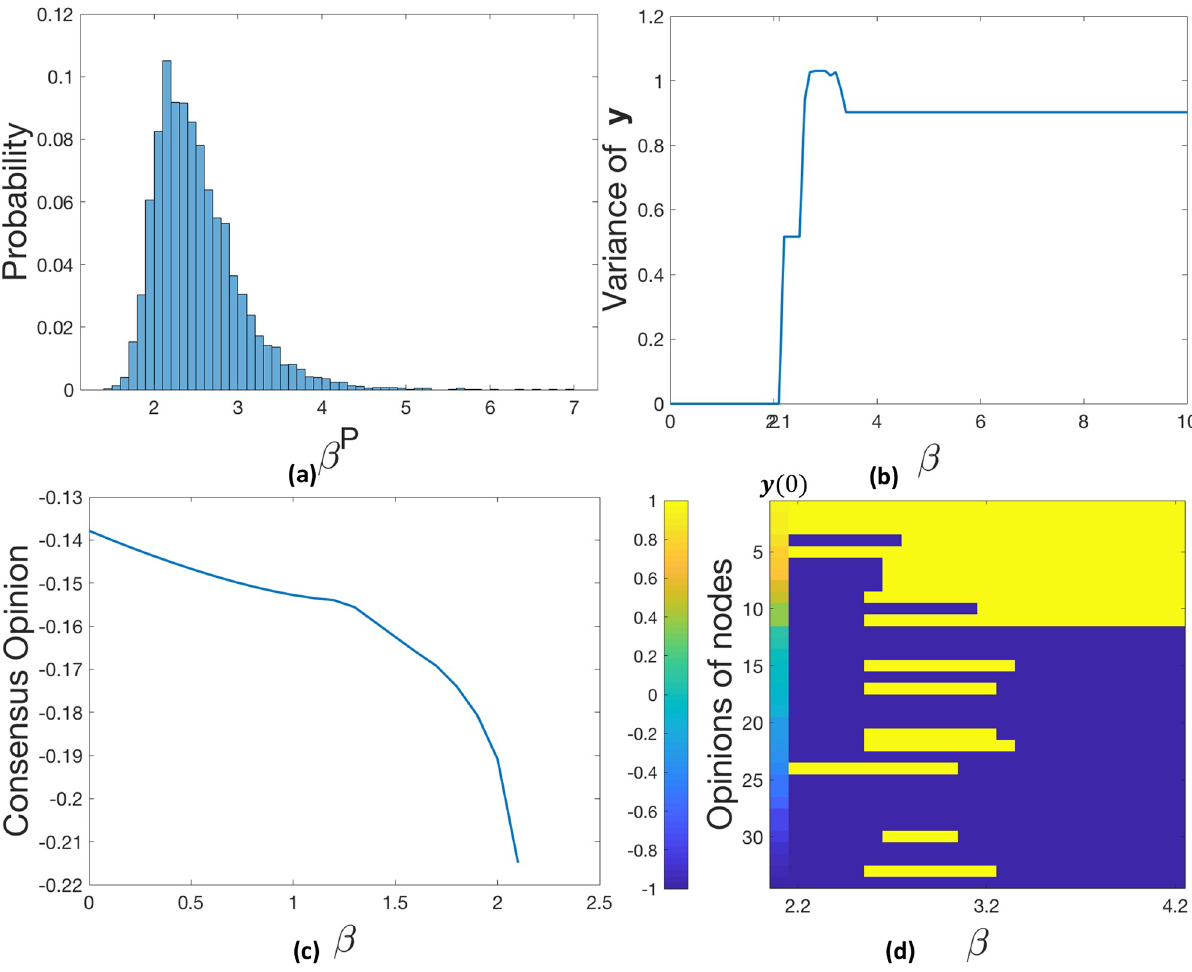
Fig 4. For the Karate network. (a) the distribution of β P for 10,000 random opinion vectors (uniform on [ − 1, 1]); For one of the opinion vectors, (b) the variance of all converged y as β increases from 0 to 10; (c) consensus opinion values for β 2 [0, 2.1]; (d) final converged opinions for each of the